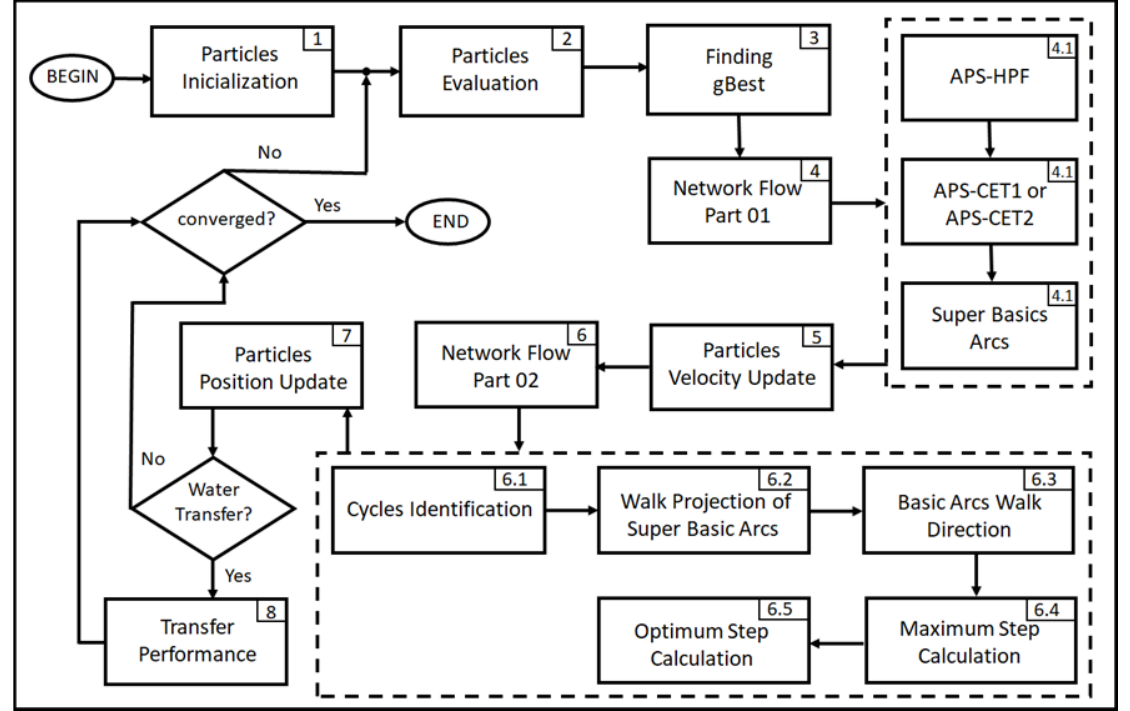
Figure 3. Proposed algorithm.